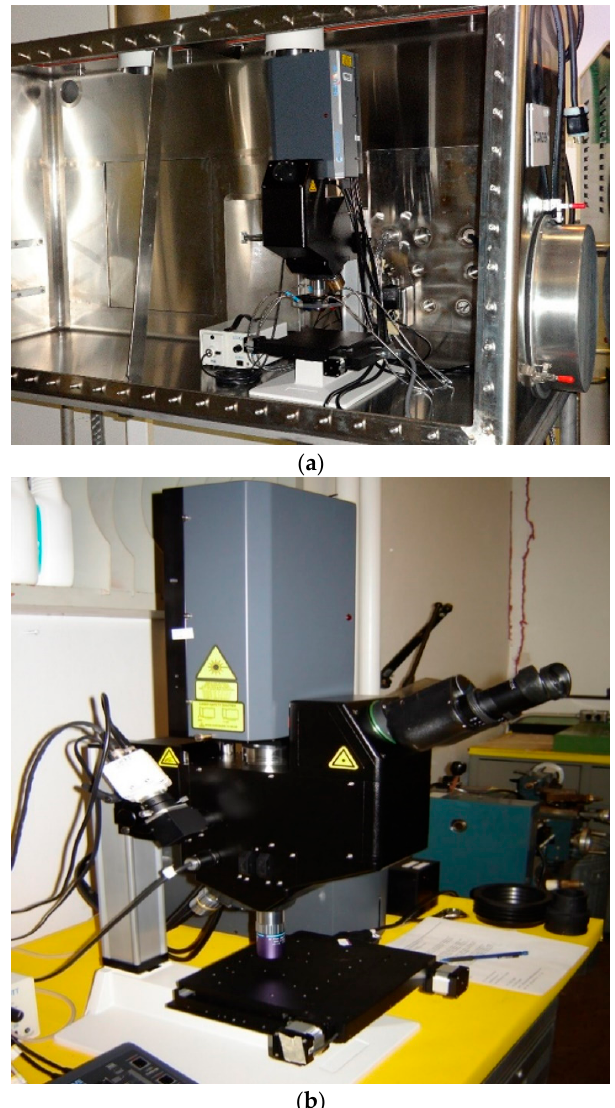
Figure 1. Quiklaze 200 laser scriber customized and coupled to a LIBS optical system: ( a ) The Quiklaze 200 laser scribe placed in a glovebox and ( b ) Quiklaze 200 laser scriber coupled to a LIBS optical collection assembly.